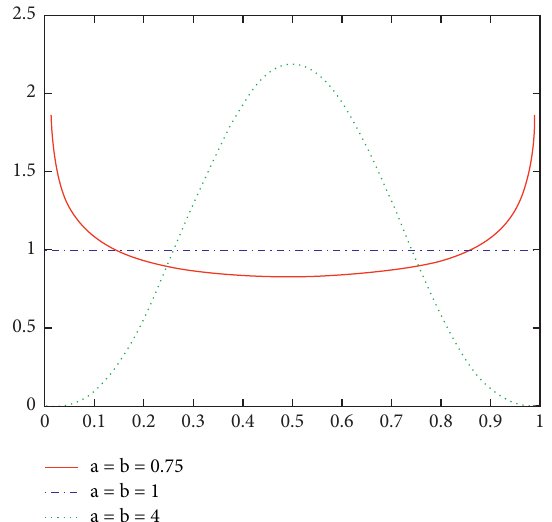
Figure 4: Beta distribution (corresponding to (a, P) taking different